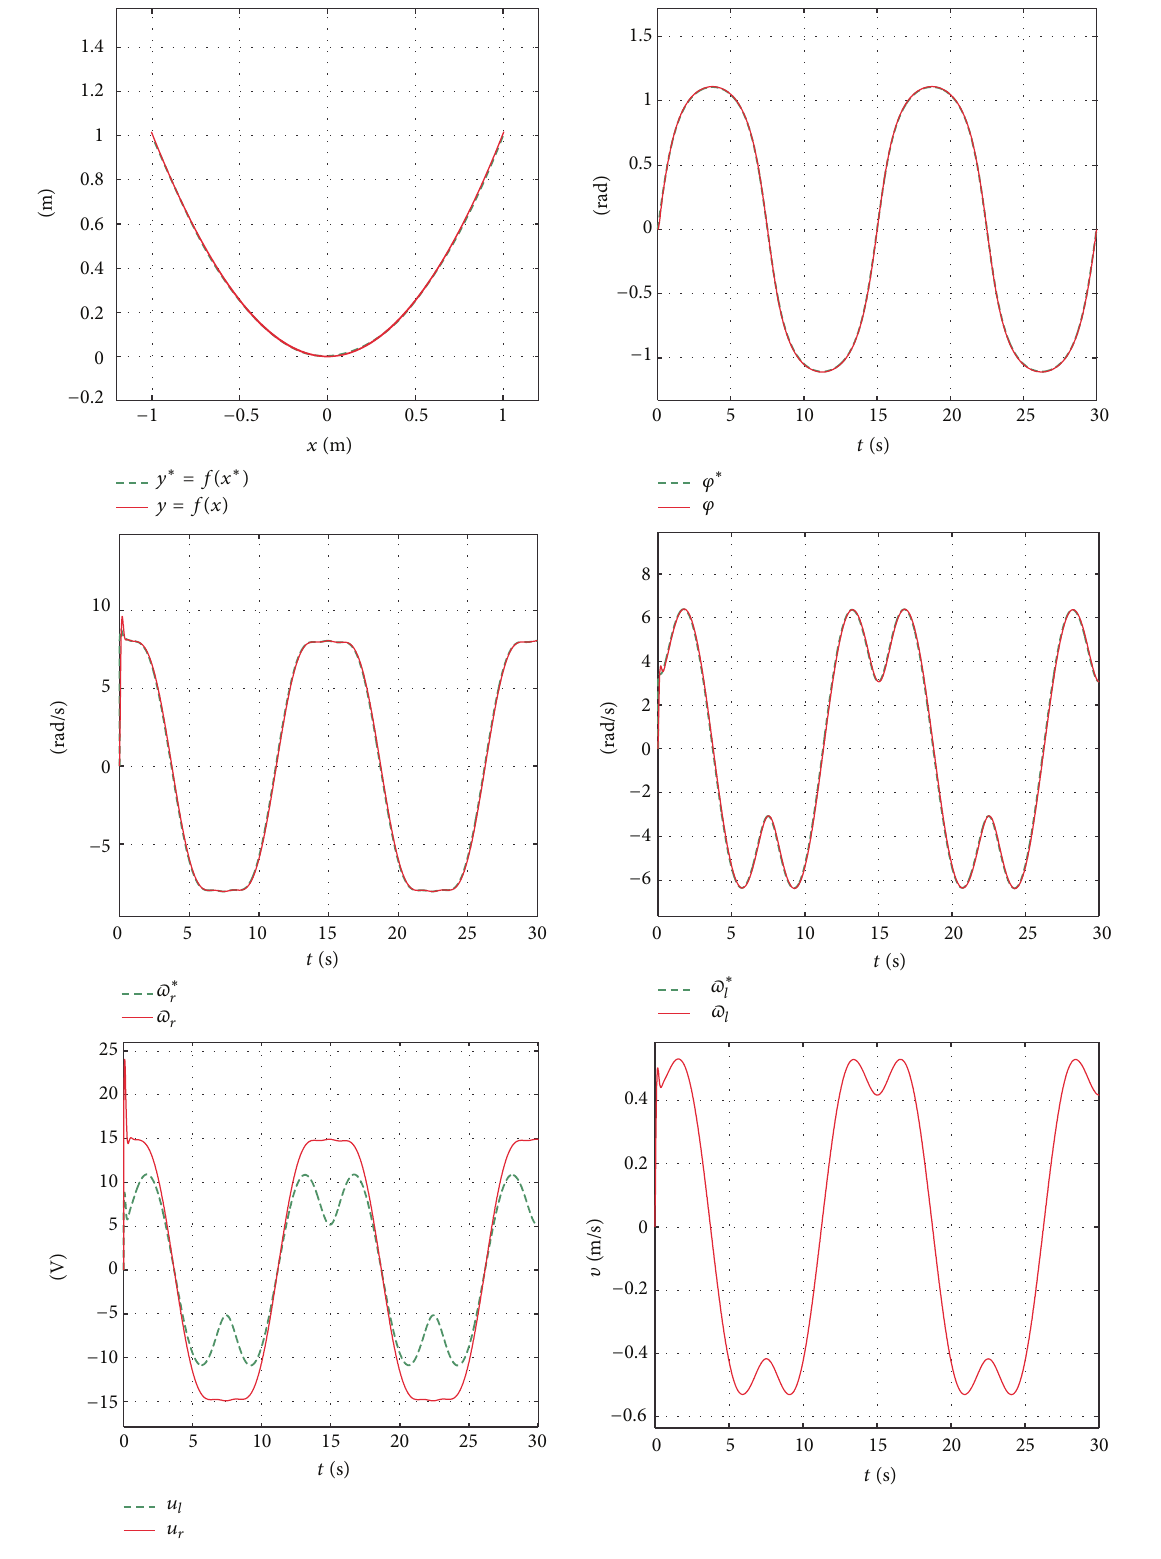
Figure 16: Simulation